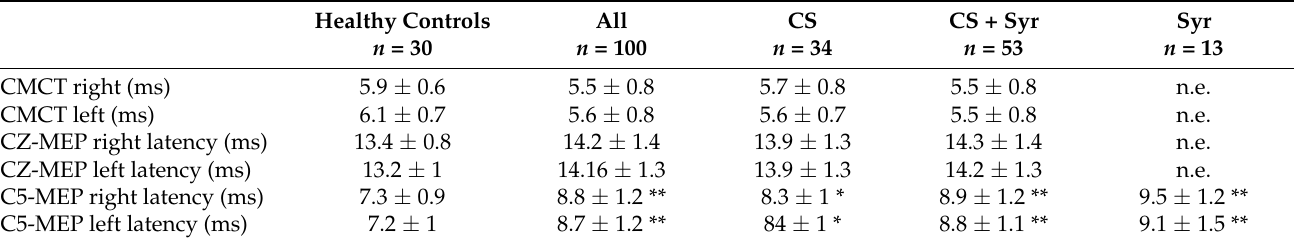
Table 2. Neurophysiological data: healthy controls and